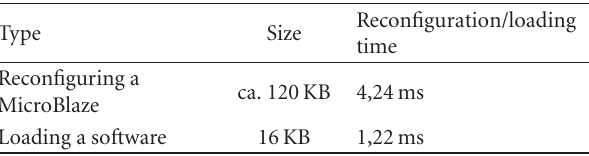
Table 5: Reconfiguration/loading times for the chosen